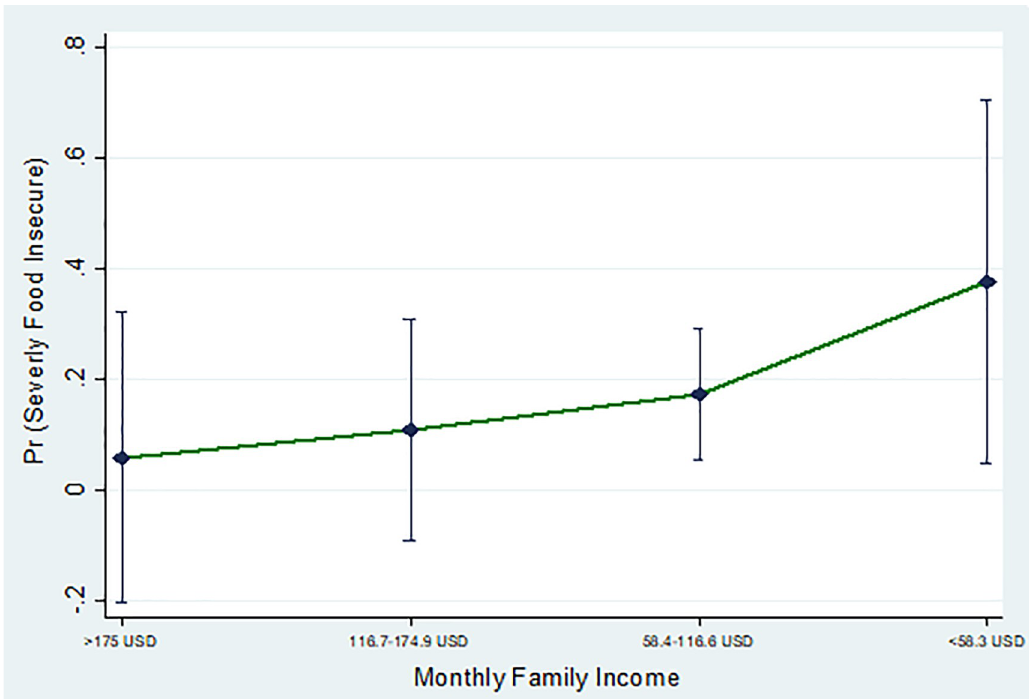
Fig 2. Predictive marginal effect of food insecurity with monthly family